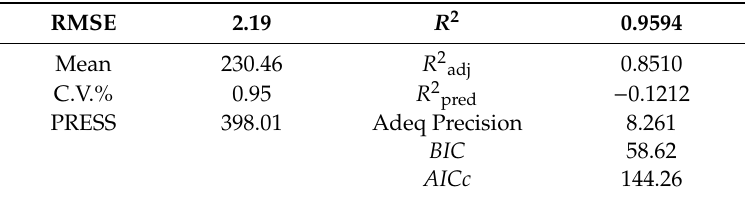
Table 10. Analysis of statistical